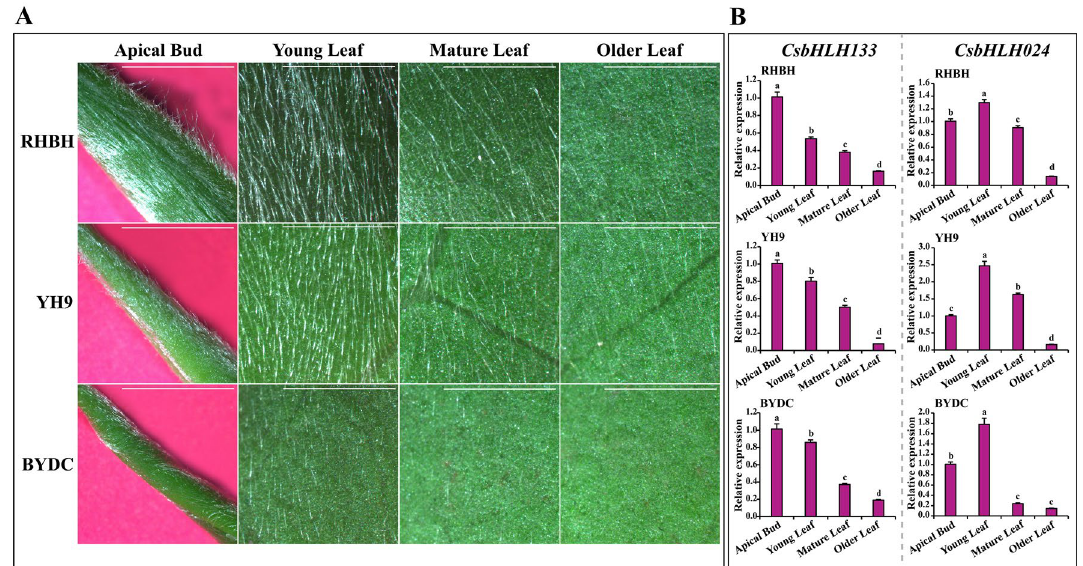
Figure 5. The trichome distribution and expression patterns of CsbHLH024 and CsbHLH133 in different tea plant cultivars. A. The trichome distribution in cultivars ‘RHBH’, ‘YH9’ and ‘BYDC’. Scale bars = 5 mm. B. The expression patterns of CsbHLH024 and CsbHLH133 in different developmental leaf tissues of different tea plant cultivars. The different letters in the figures indicate significantly different values (P < 0.05, Tukey’s test). For all samples, three biological replicates and three technical replicates of each biological replicate were performed.